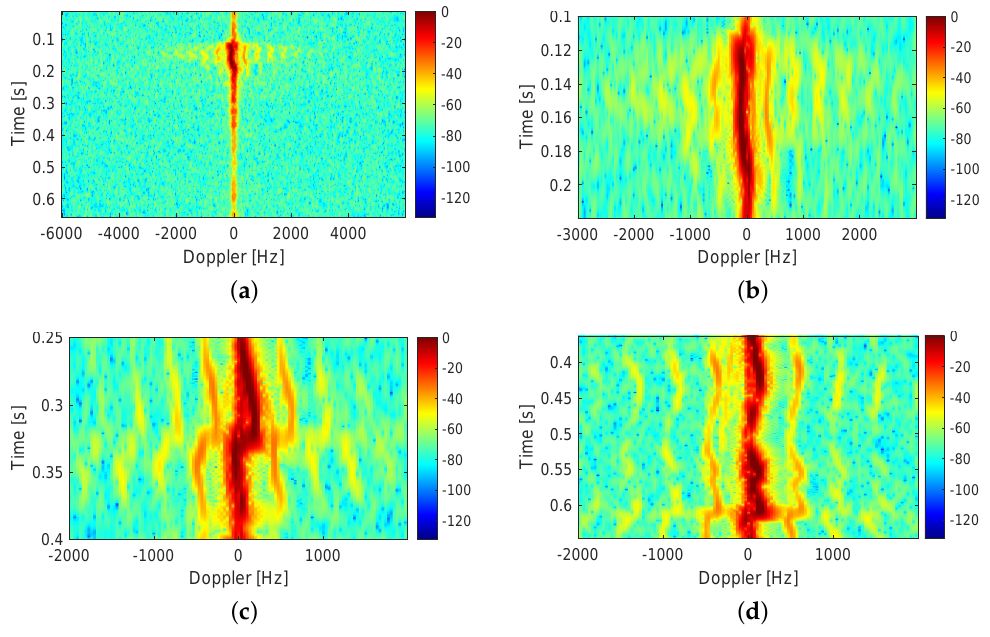
Figure 7. Results obtained from mosquito measurements. ( a ) Full spectrogram of the first measure- ment. ( b ) Excerpt of the spectrogram in Figure 7a. ( c ) Spectrogram of the second measurement. ( d ) Spectrogram of the third measurement.